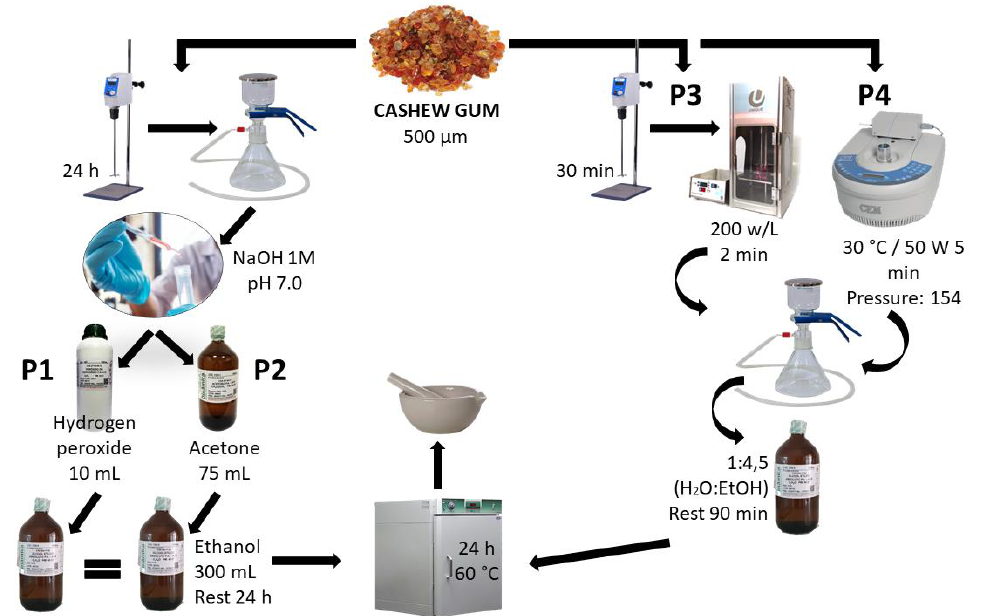
Figure 1. Flowchart of the four methodologies used to purify the cashew gum.